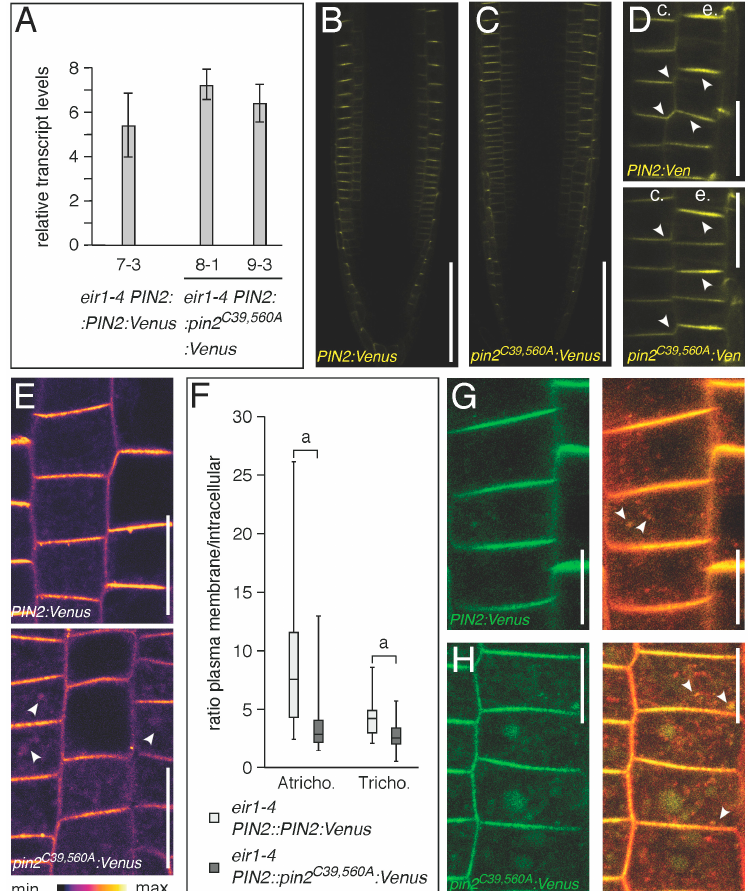
Figure 7. Expression pattern and localization of PIN2::pin2 C39,560A :Venus reporter lines. ( A ) Relative transcript levels of PIN2::PIN2:Venus and two PIN2::pin2 C39,560A Venus lines at 6 DAG. Two biological repetitions have been used for each sample, with transcripts normalized to expression of EF1a (At1g07940). Bars indicate standard deviations. One-way ANOVA with